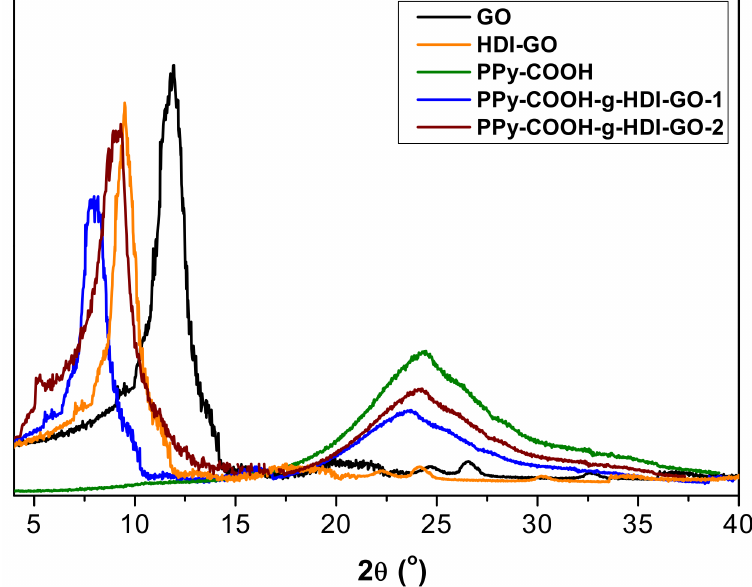
Figure 6. XRD patterns of PPy-COOH, GO, HDI-GO, and the grafted